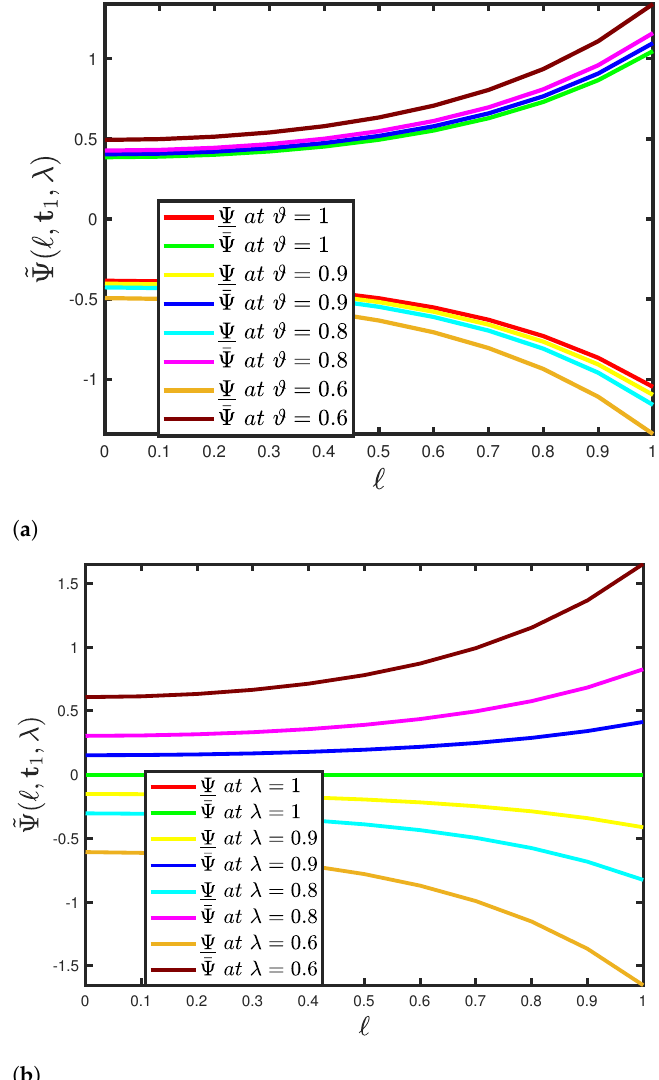
Figure 14. Two-dimensional simulation of ˜ Ψ ( (cid:96) , t 1 ; λ ) of Problem (4): ( a ) Ψ ( (cid:96) , t 1 ; λ ) and ¯ Ψ ( (cid:96) , t 1 ; λ ) when fuzzy CFD is considered to have an uncertainty parameter λ ∈ [ 0,1 ] and t 1 = 0.7; and ( b ) Ψ ( (cid:96) , t ) and ¯ Ψ ( (cid:96) , t ) when fuzzy CFD is considered to have a fractional order ϑ = 0.7 and 1 ; λ 1 ; λ t 1 =